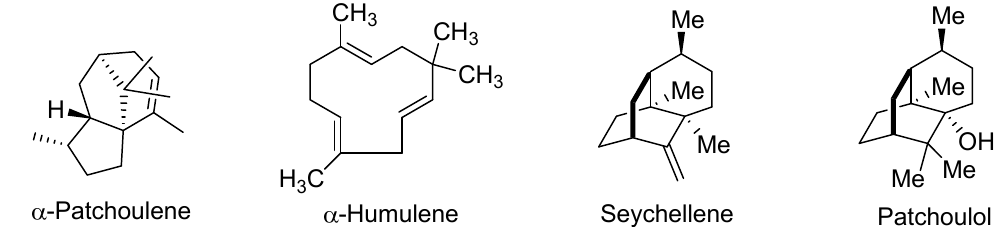
Figure 1. Chemical structures of abundant compounds identified in the essential oil of Valeriana pilosa roots.